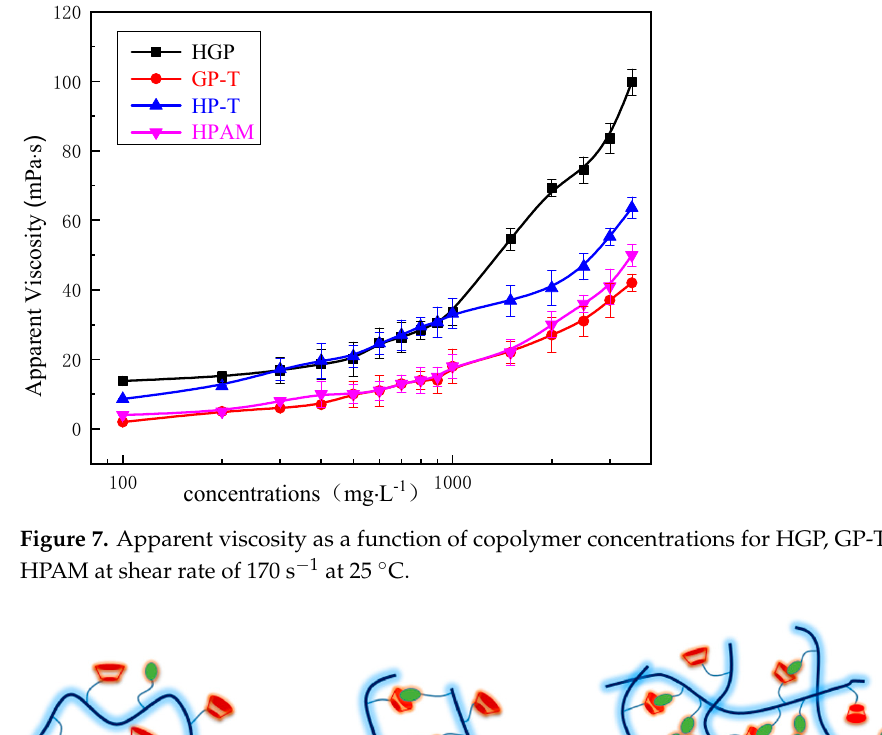
Figure 8. The thickening mechanism of HGP.